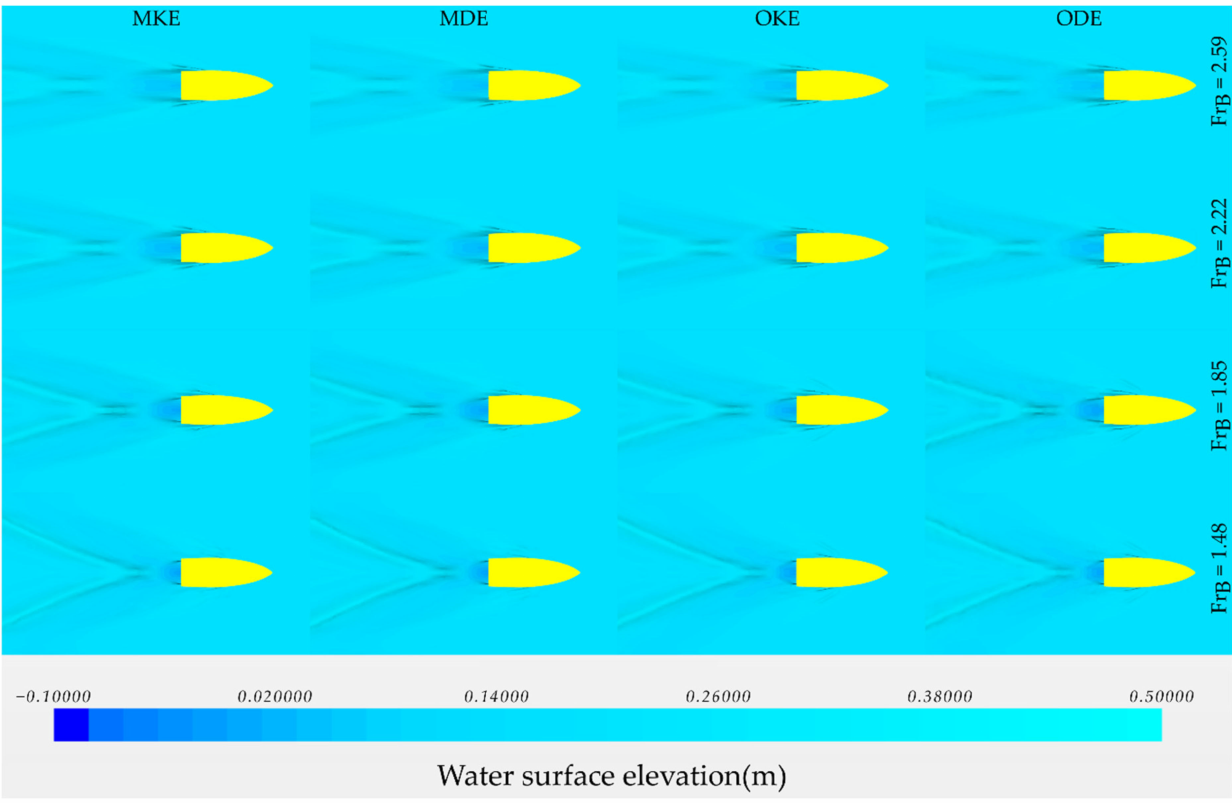
Figure 13. Water surface elevation around the vessel, computed using different CFD